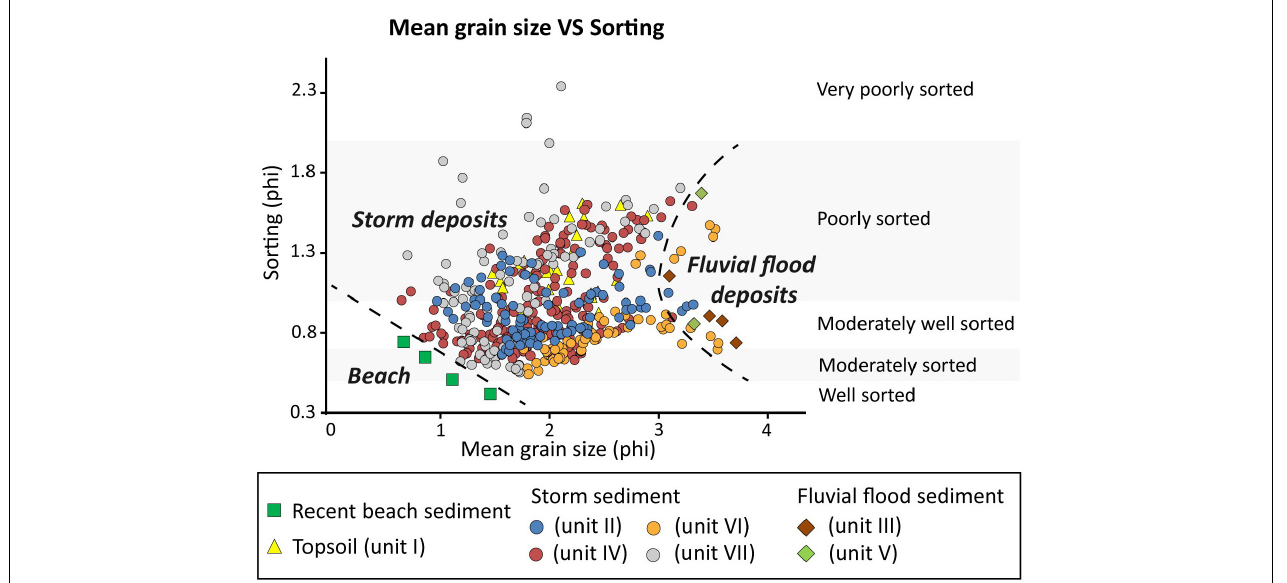
FIGURE 10 | Plotting statistical values of the mean grain size versus sorting. The number of sediments plotted is as follows: recent beach ( n = 4), Unit I ( n = 27), Unit II ( n = 97), Unit III ( n = 4), Unit IV ( n = 177), Unit V ( n = 2), Unit VI ( n = 69), and Unit VII ( n = 94). The dashed line divides the zone of a statistical distribution pattern of beach sediment, storm sediment, and FF